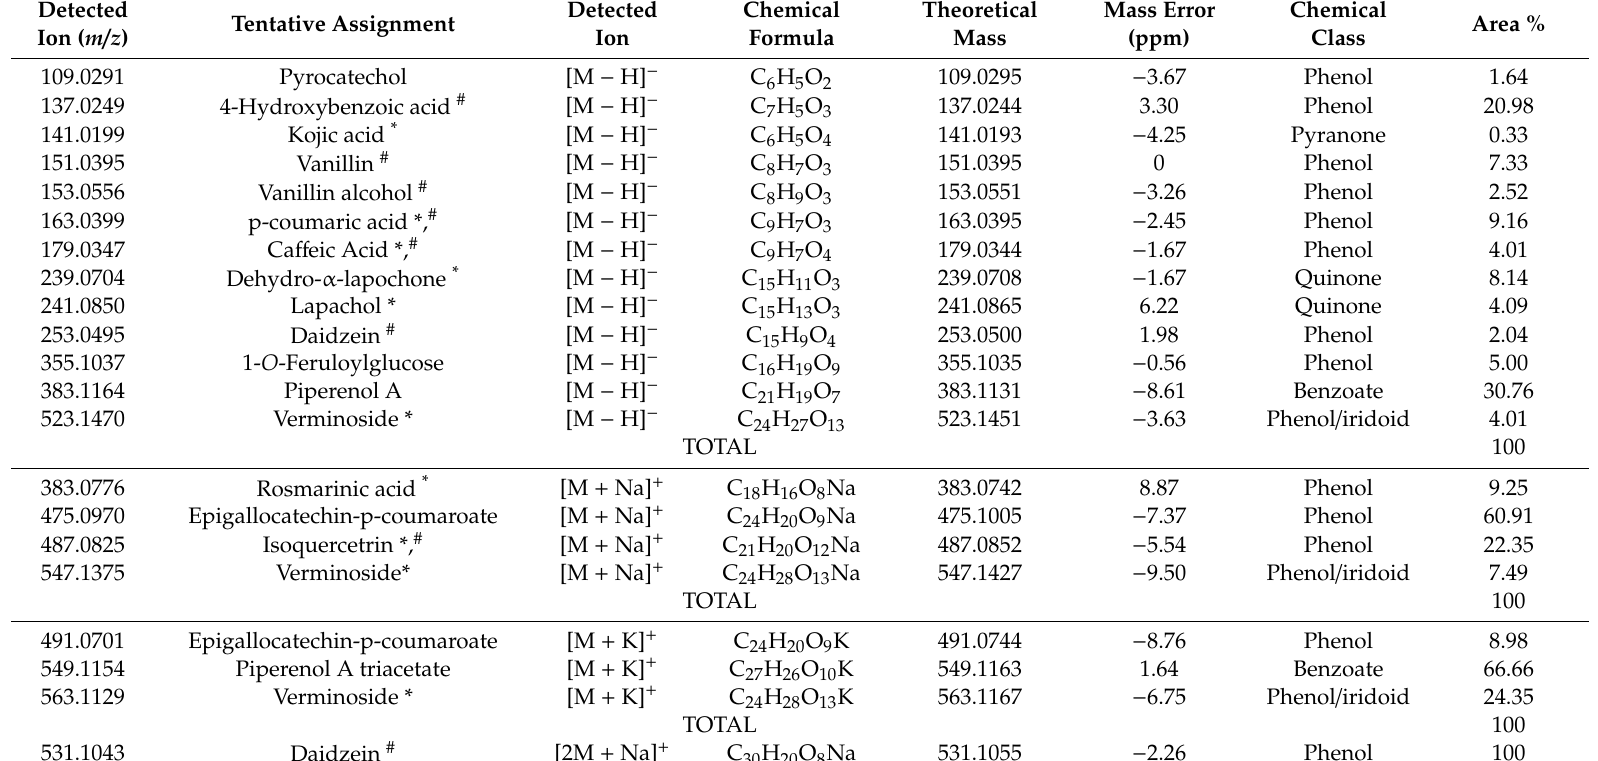
Table 2. Tentative identification of phenol-like compounds in the fruits of Kigelia africana , along with the kind of detected ion (deprotonated [M − H] − , adduct ion [M + Na] + or [M + K] + or adduct ion of dimer [2M + Na] + ), its chemical formula and theoretical mass. The mass error (part per million, ppm) and the chemical class of each assignment are also